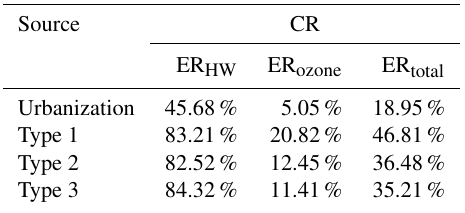
Table 4. Contribution rate of urbanization and synoptic weather pattern to